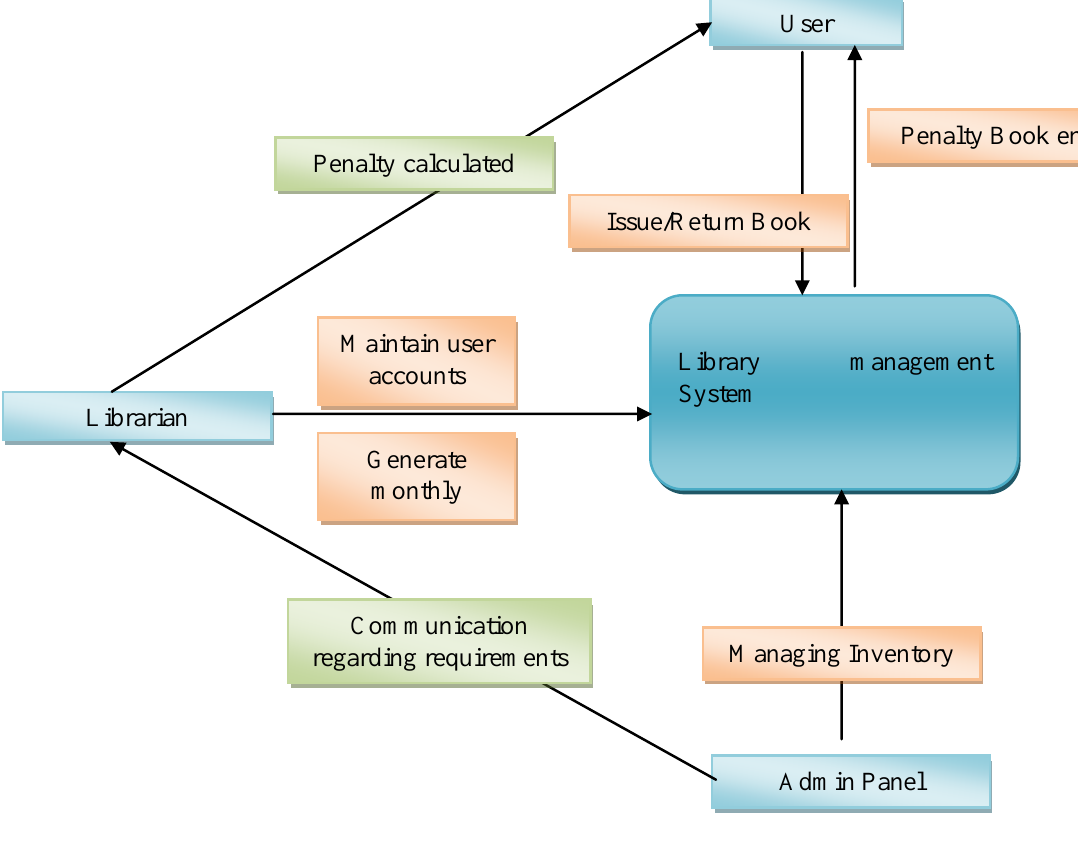
Figure 4. Data flow in the library management